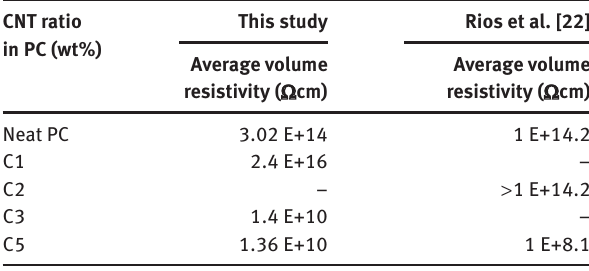
Table 11 Comparison of electrical test results with Rios’s study